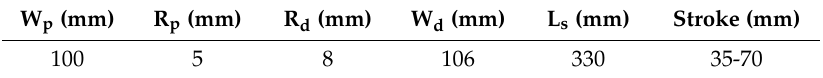
Table 8. Parameters of the U-drawing experimental test.